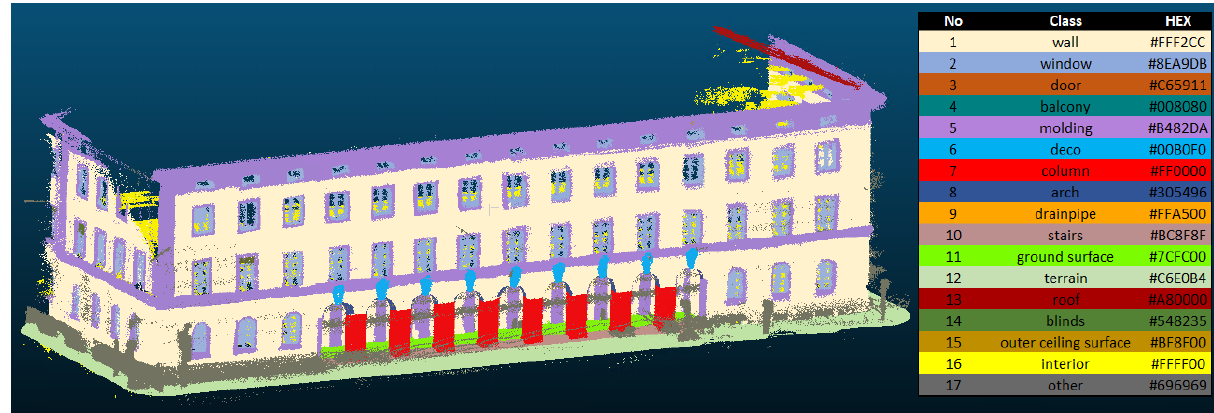
Figure 4. One of the TUM-FAC¸ADE buildings showing the color-coded points classes.